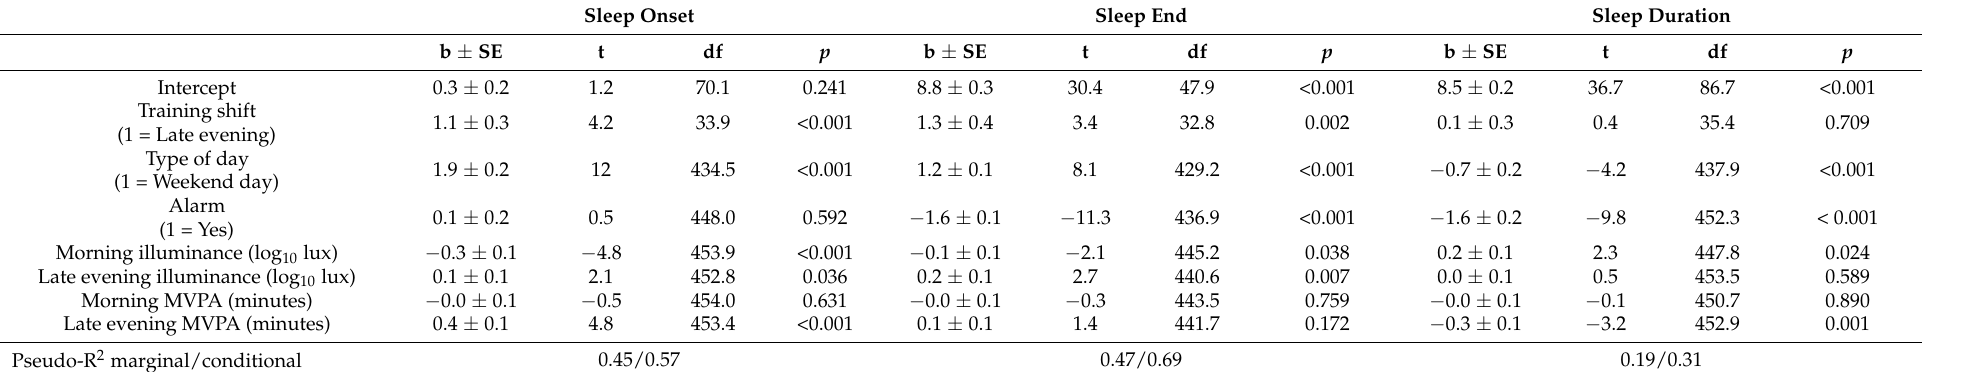
Table 3. Mixed-effects linear regressions for estimating sleep parameters (454